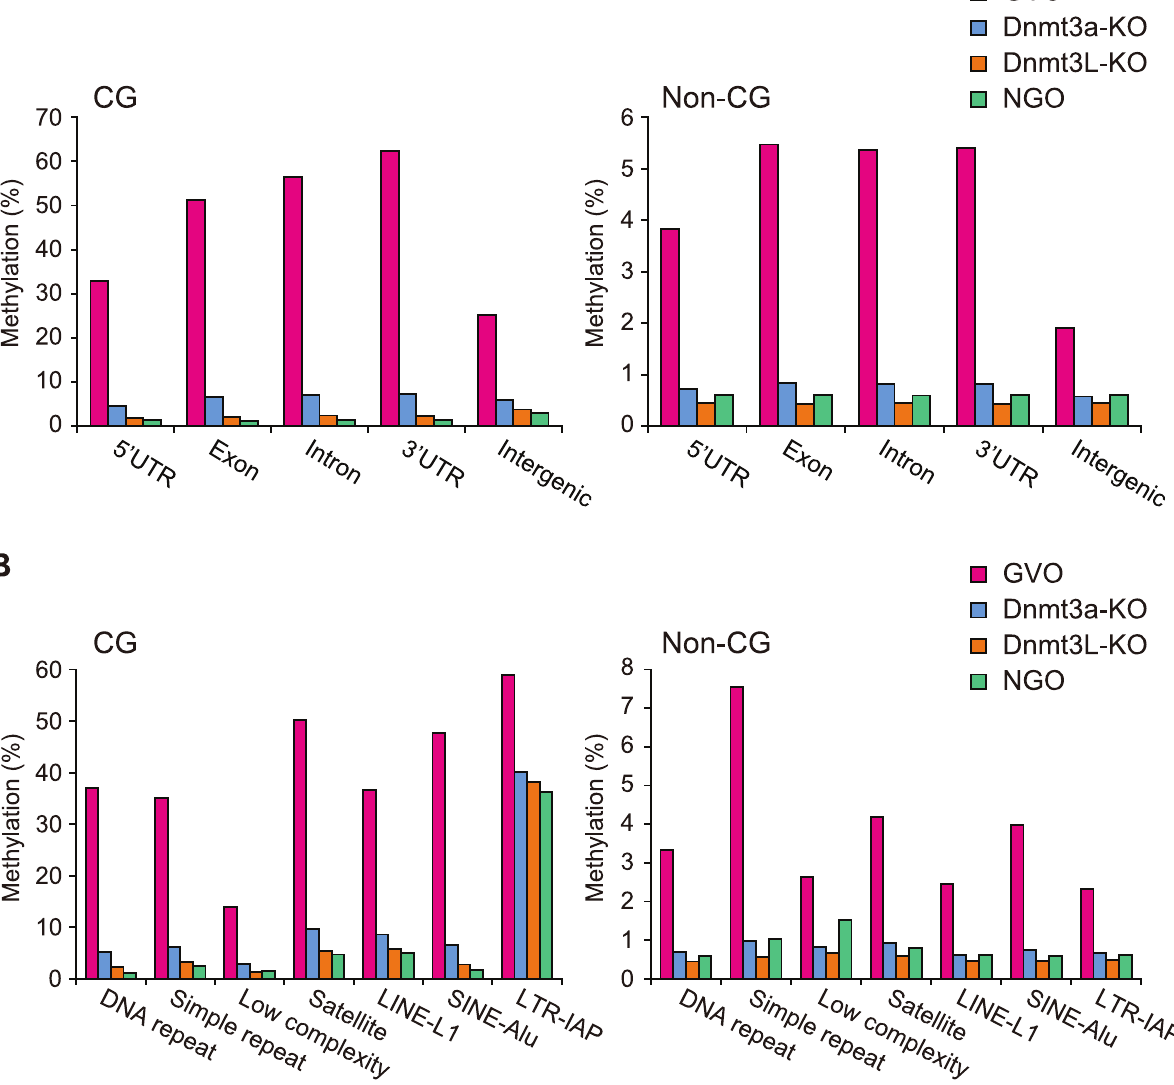
Figure 5. CG and non-CG methylation levels in different genomic elements in NGOs, GVOs, Dnmt3a-KO, and Dnmt3L-KO. (A) Levels of CG methylation and non-CG methylation in intragenic and intergenic regions. Intragenic regions are further divided into 5 9 UTRs, exons, introns, and 3 9 UTRs according to the RefSeq annotations. (B) Levels of CG methylation and non-CG methylation in different types of repetitive elements. Annotation for repetitive elements was obtained from the UCSC Genome